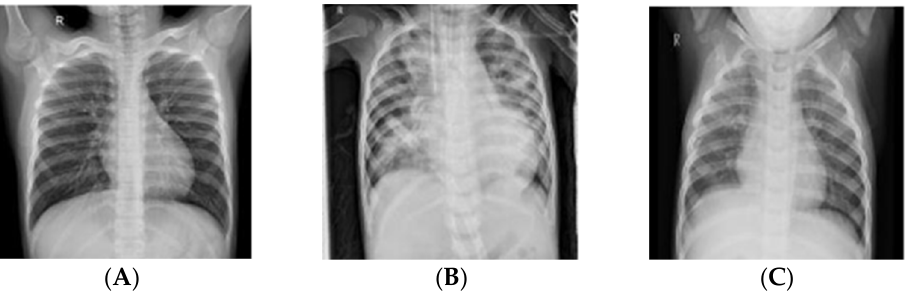
Figure 1. Pediatric Chest X-ray images; normal ( A ), bacterial pneumonia ( B ), and viral pneumonia ( C ).